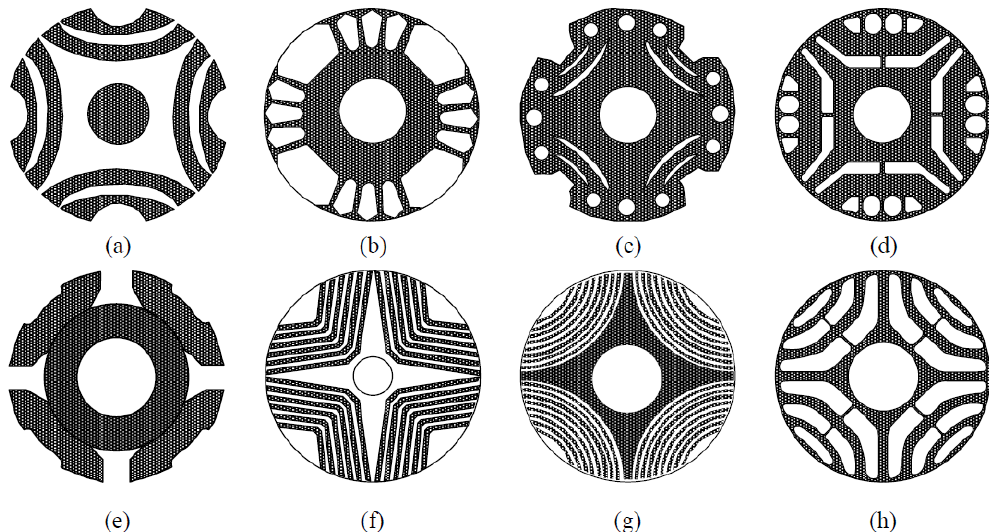
Figure 7. Evolution of synchronous reluctance machines (SynRMs) showing different rotor designs [41] ( a ) the original Kostko rotor; ( b ) rotor adapted from an induction motor rotor; ( c ) rotor with multiple barriers; ( d ) rotor with saturable bridges; ( e ) segmented rotor; ( f ) axially laminated V rotor ( g ) axially laminated U-rotor; ( h ) modern transverse laminated rotor. The torque T, and power factor, cosφ, of the SynRM is given by Equations (4) and (5), where L d and L q are d- and q-axis inductances respectively, i d and i q are d- and q-axis currents respectively and